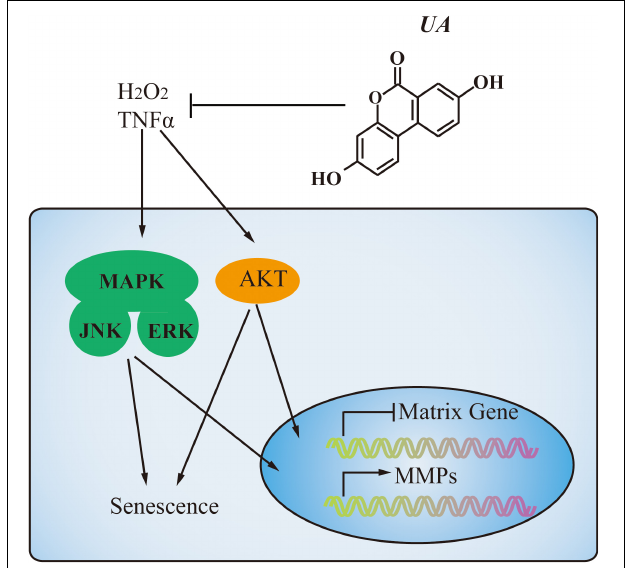
FIGURE 7 | A proposed model of the mechanism. During degeneration, MAPK and PI3K/Akt pathways were activated by TNF α stimulation. UA treatment could decrease MMPs expression and increase matrix gene expression through inhibiting the activation of JNK, ERK, and Akt. Meanwhile, UA could prevent NP cell senescence as